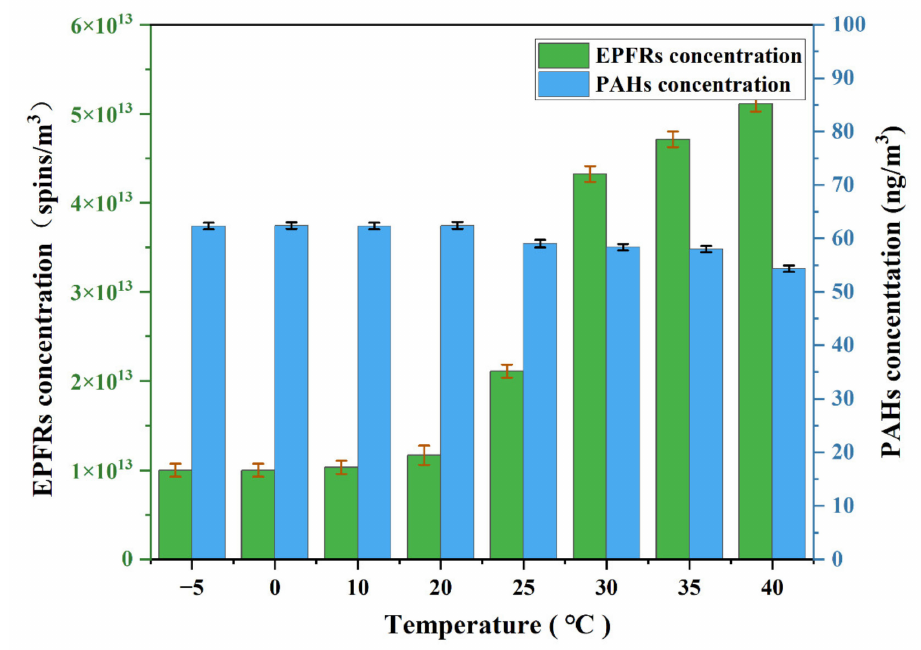
Figure 6. EPFR and PAH concentrations in PM 2.5 samples at temperatures of − 5–40 ◦